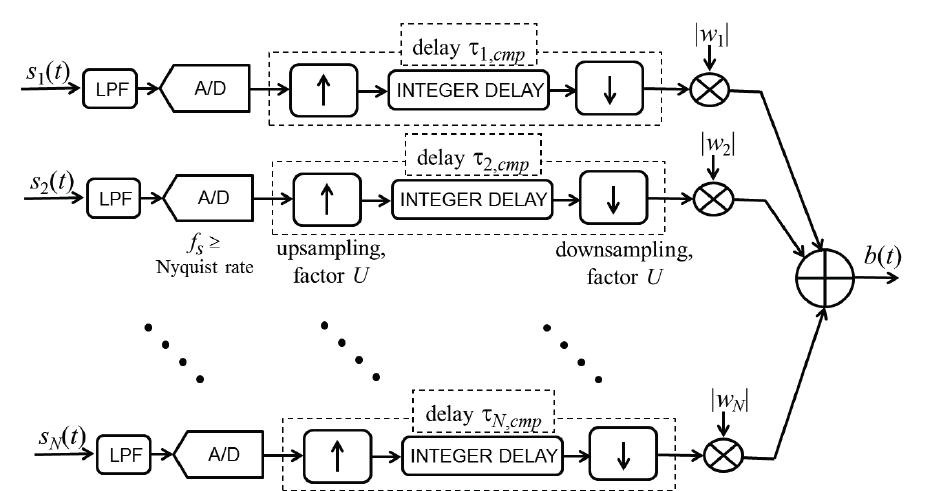
Figure 12. Schematic of end-fire beamformer using complex weights, where delays are implemented using digital fractional delay